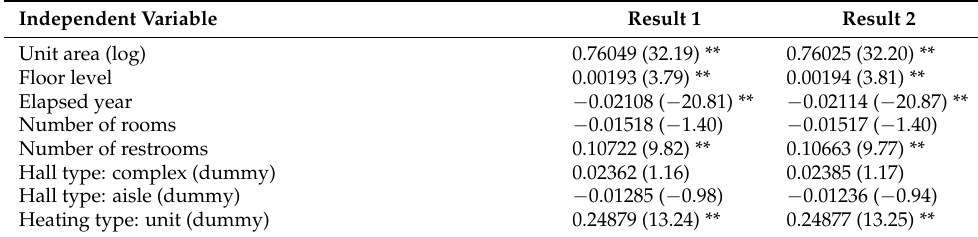
Table 7. Regression results